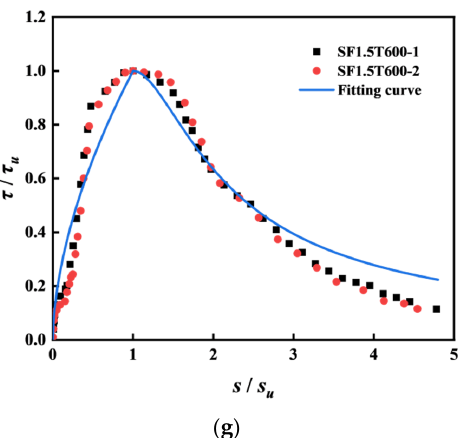
Figure 14. Partial test curves and fitted curves of ( a ) SF0.5T20 group, ( b ) SF1.0T20 group, ( c ) SF0.5T200 group, ( d ) SF1.0T400 group, ( e ) SF0.5T600 group, ( f ) SF1.0T600 group, and ( g ) SF1.5T600 group.